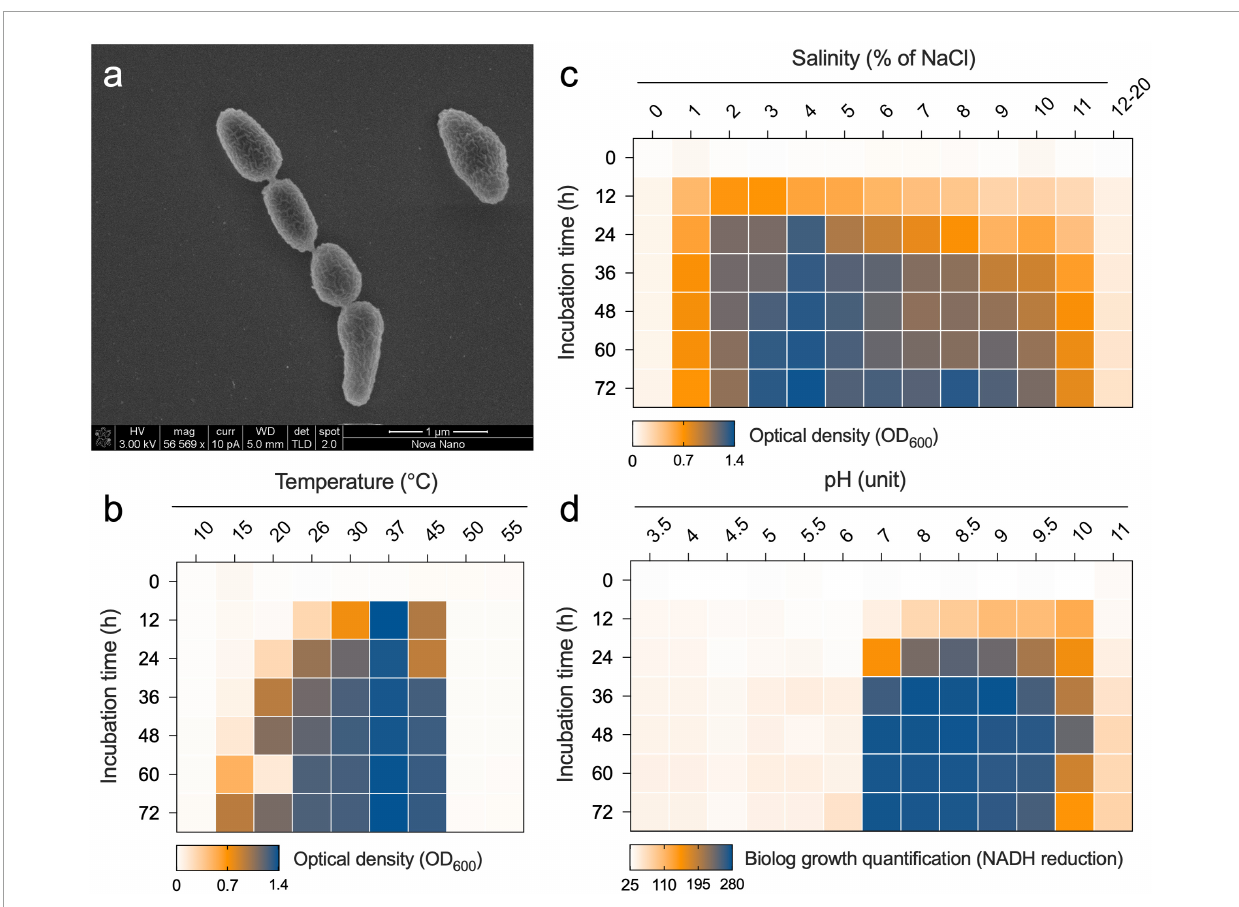
FIGURE4 (a) Transmission electron micrographs of Nit1536 T . The bar length is 1 µ m. Growth of Nit1536 T at different (b) temperatures and (c) salinities (% of NaCl) is reported as the average value of OD 600 ( n = 3). (d) Metabolism of Nit1536 T under different pH is analyzed using Biolog PM and reported as the quantity of dye